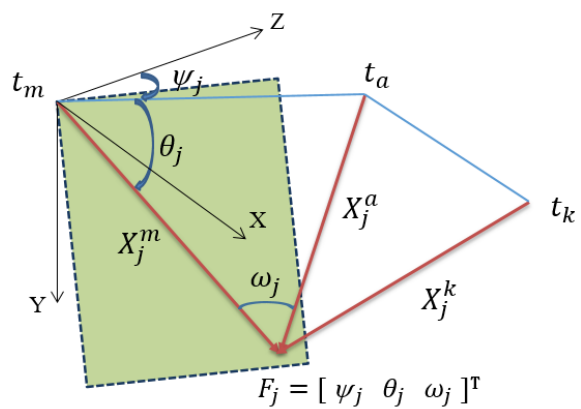
Figure 1. The parameterization of 3D feature points based on the parallax